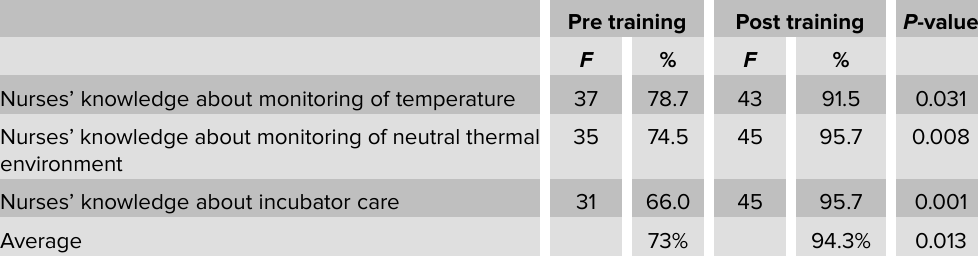
Figure 3 : Distribution of the study sample according to the years of experience, N = 47. Table 1: Nurses’ knowledge about hypothermia ( n = 47).